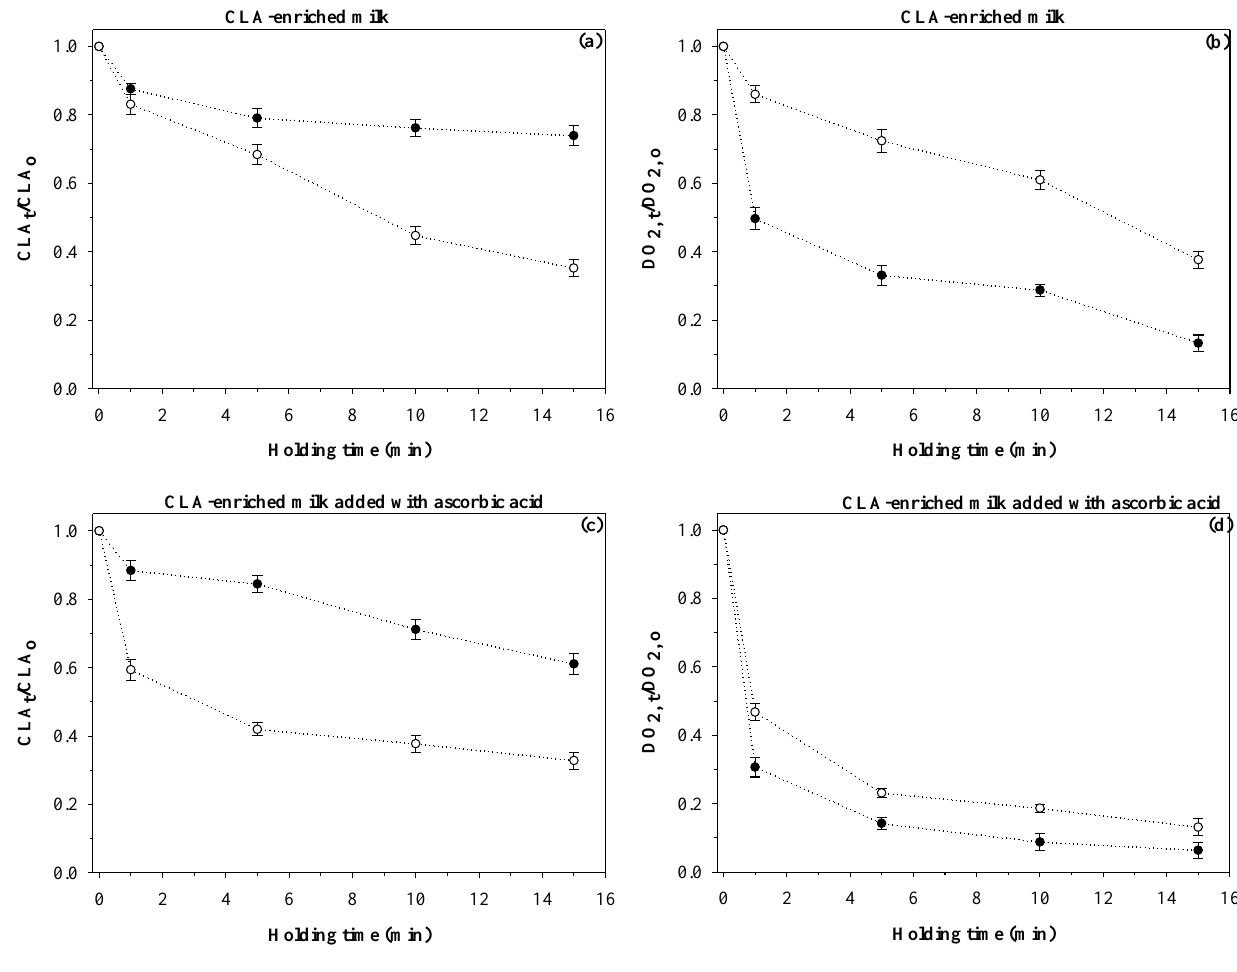
Figure 2. Changes in conjugated linoleic acid (CLA) and dissolved oxygen (DO 2 ) in CLA-enriched milk treated at 120 °C and either 600 MPa (●) or 0.1 MPa